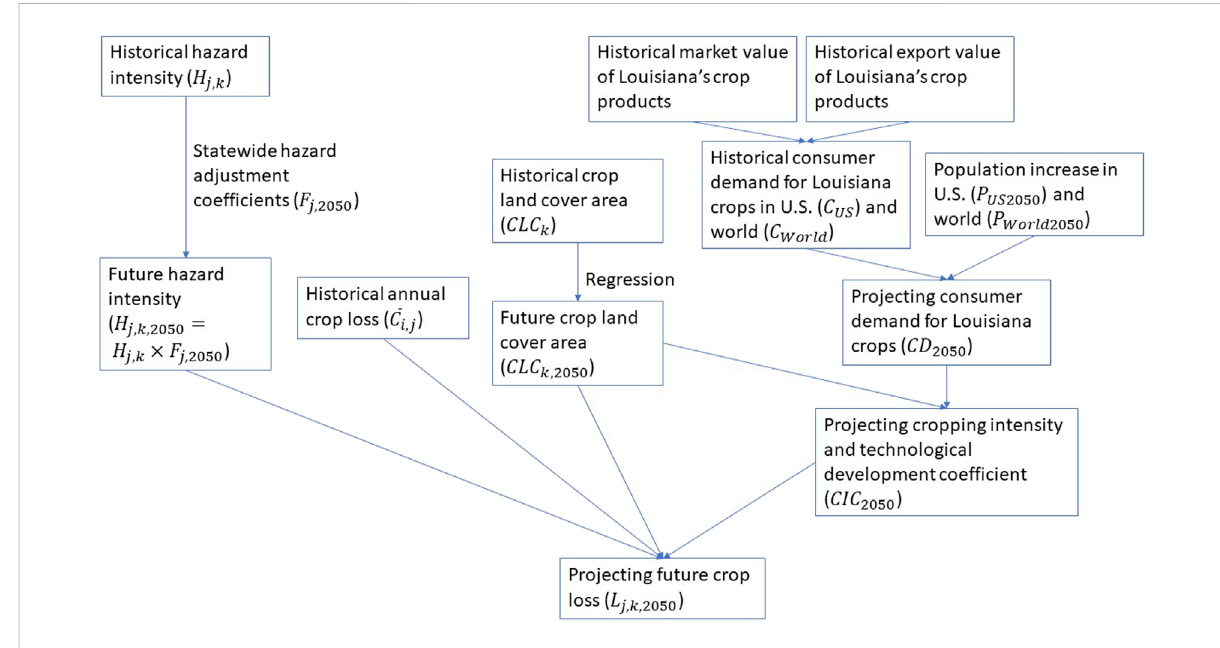
FIGURE 1 Methodological framework.